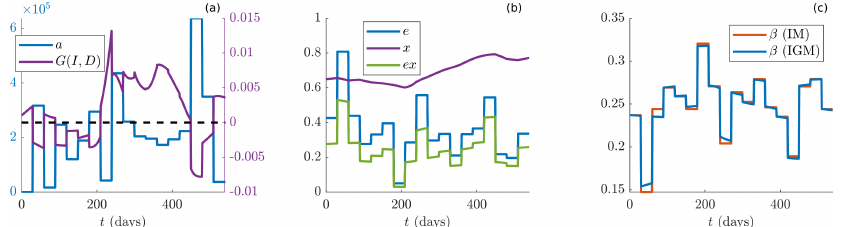
Figure 6. Subplot ( a ): time course of the estimated threshold parameter a (blue line, left ordinate axis) and of the “game-switching term” G ( I , D ) (violet line, right ordinate axis). The dashed black lines represents the 0 of the right coordinate axis. For values of G ( I , D ) bigger than 0, the population plays a Harmony game, while for values lower that 0, a Prisoner’s Dilemma game is used. Subplot ( b ): time curse of the estimated efficacy parameter e (blue line), the simulated cooperation x ( t ) (violet line) and of the product the product ex (green line). Subplot ( c ): time course of β for the two models (red line for IM, blue line for